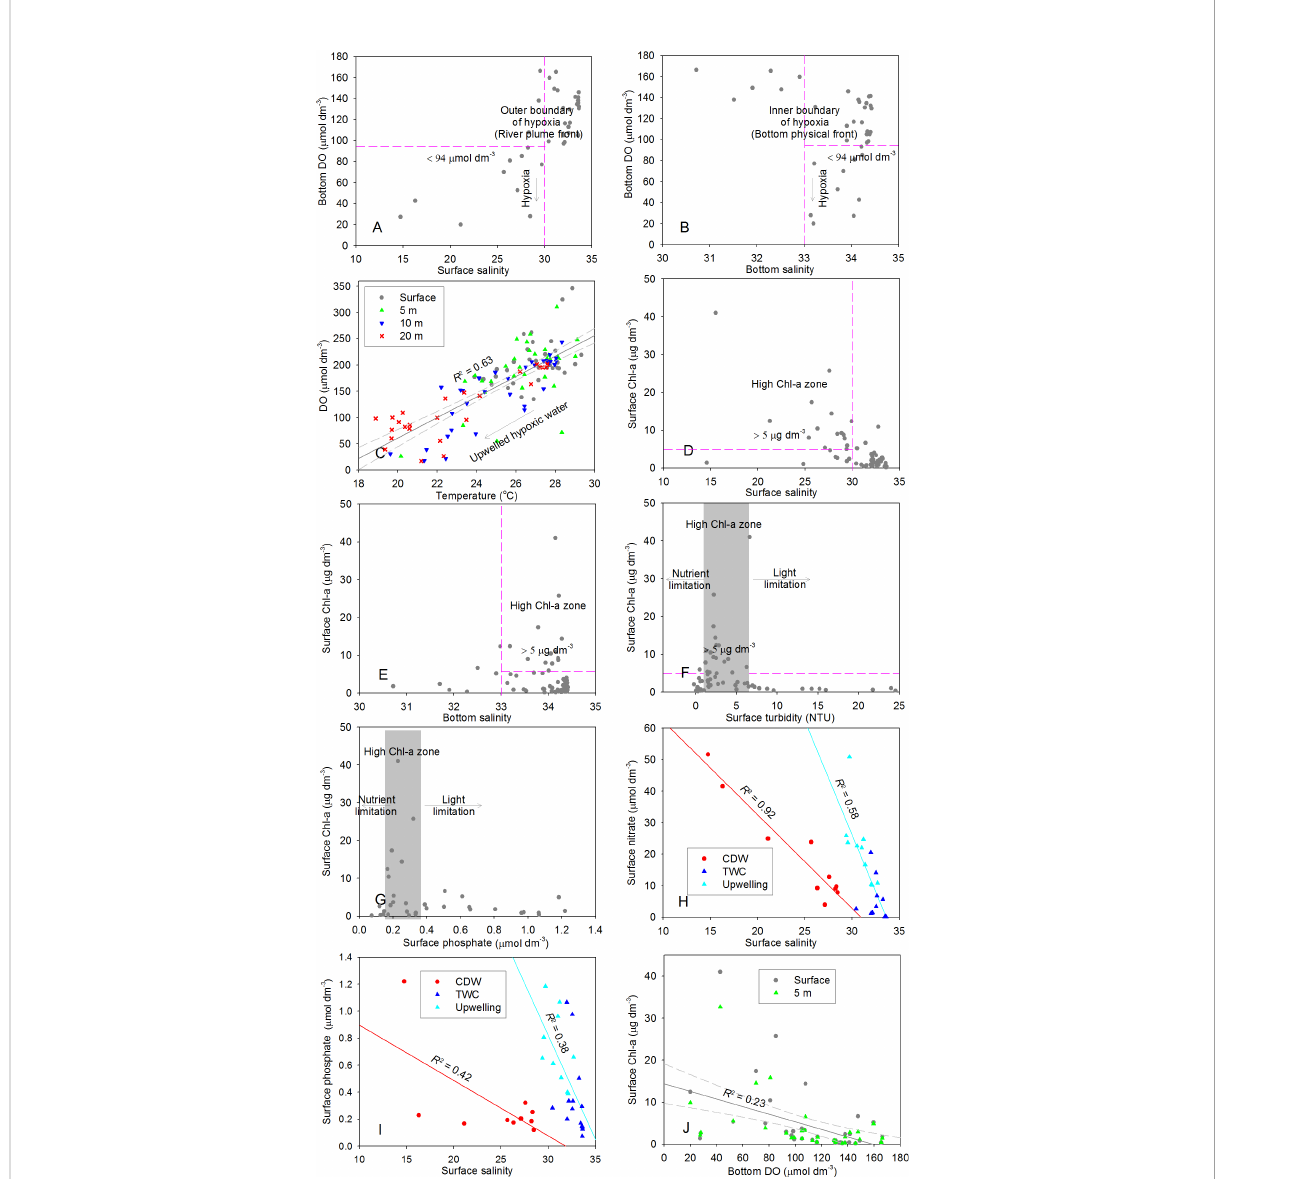
FIGURE 7 Relationships between the related variables off the CE in summer. (A) Bottom DO and surface salinity; (B) Bottom DO and bottom salinity; (C) DO and temperature in upper layers; (D) surface Chl-a and surface salinity; (E) surface Chl-a and bottom salinity; (F) surface Chl-a and surface turbidity; (G) surface Chl-a and surface phosphate (the relationship between surface Chl-a and nitrate shows similarity and hence is not shown); (H) surface nitrate and surface salinity in different masses; (I) surface phosphate and surface salinity in different masses; (J) surface Chl-a and bottom DO. The general threshold of hypoxia in panels a and b was operationally de fi ned as a low DO concentration of < 94 m mol dm -3 (equivalent to ~3 mg dm -3 ), as also adopted by previous studies (Chen et al., 2007; Zhou et al., 2017); the grey area in (F, G) generally indicates the high Chl-a region with favorable light and nutrient